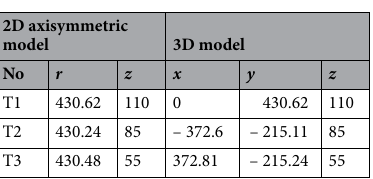
Table 5. The position of the temperature reading points under the wheel